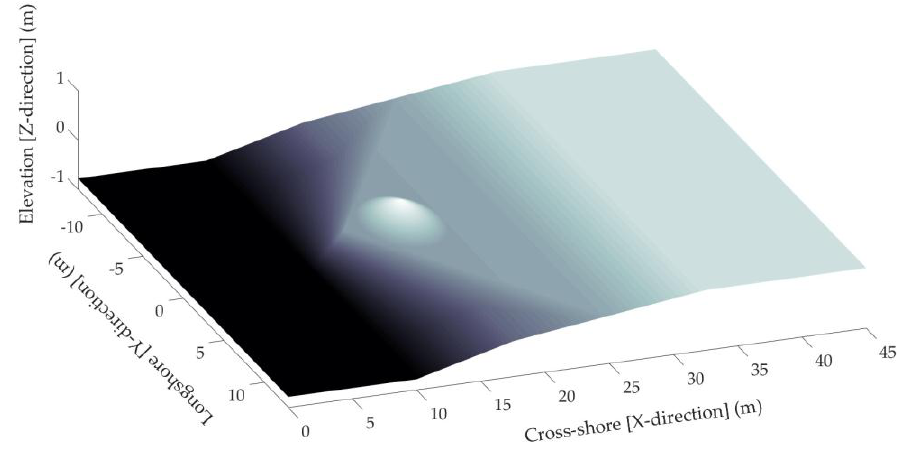
Figure 1. The bathymetry provided with the benchmark problem